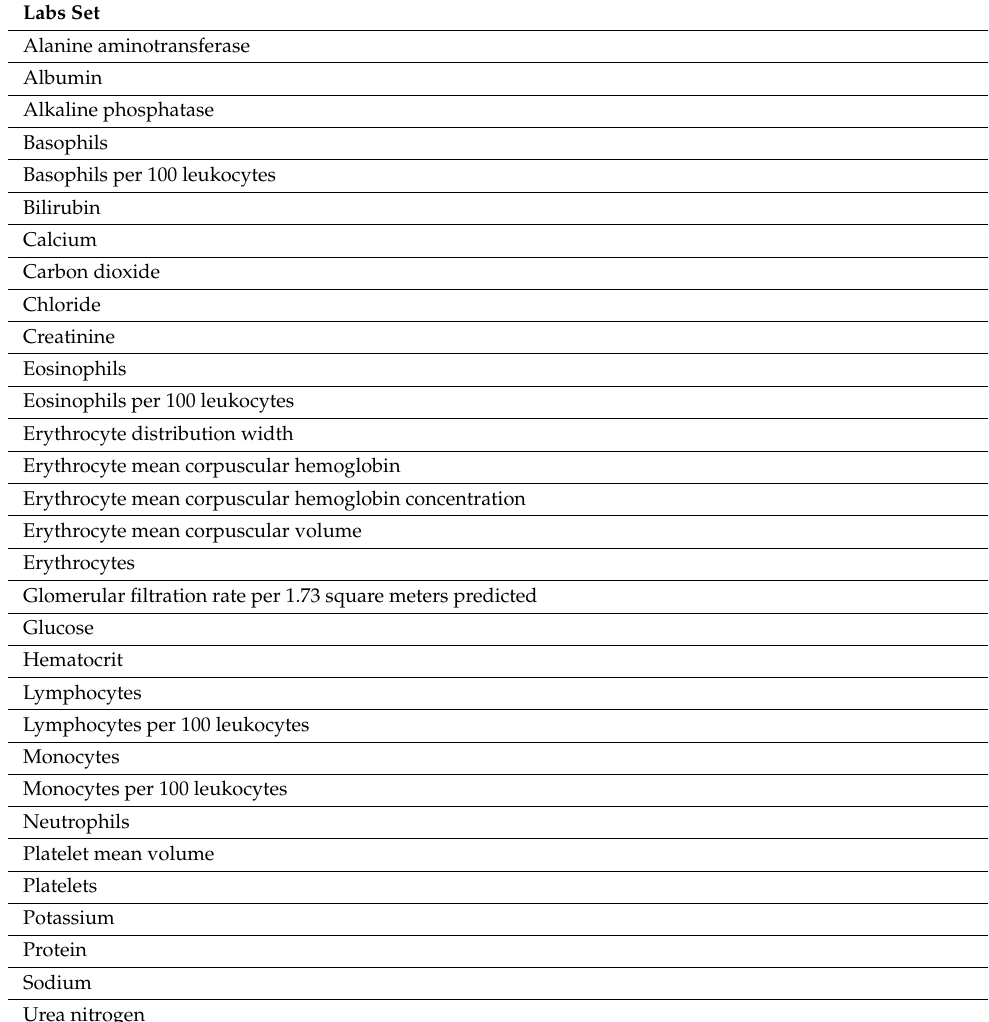
Table A1. Variables included in “labs” and “curated”